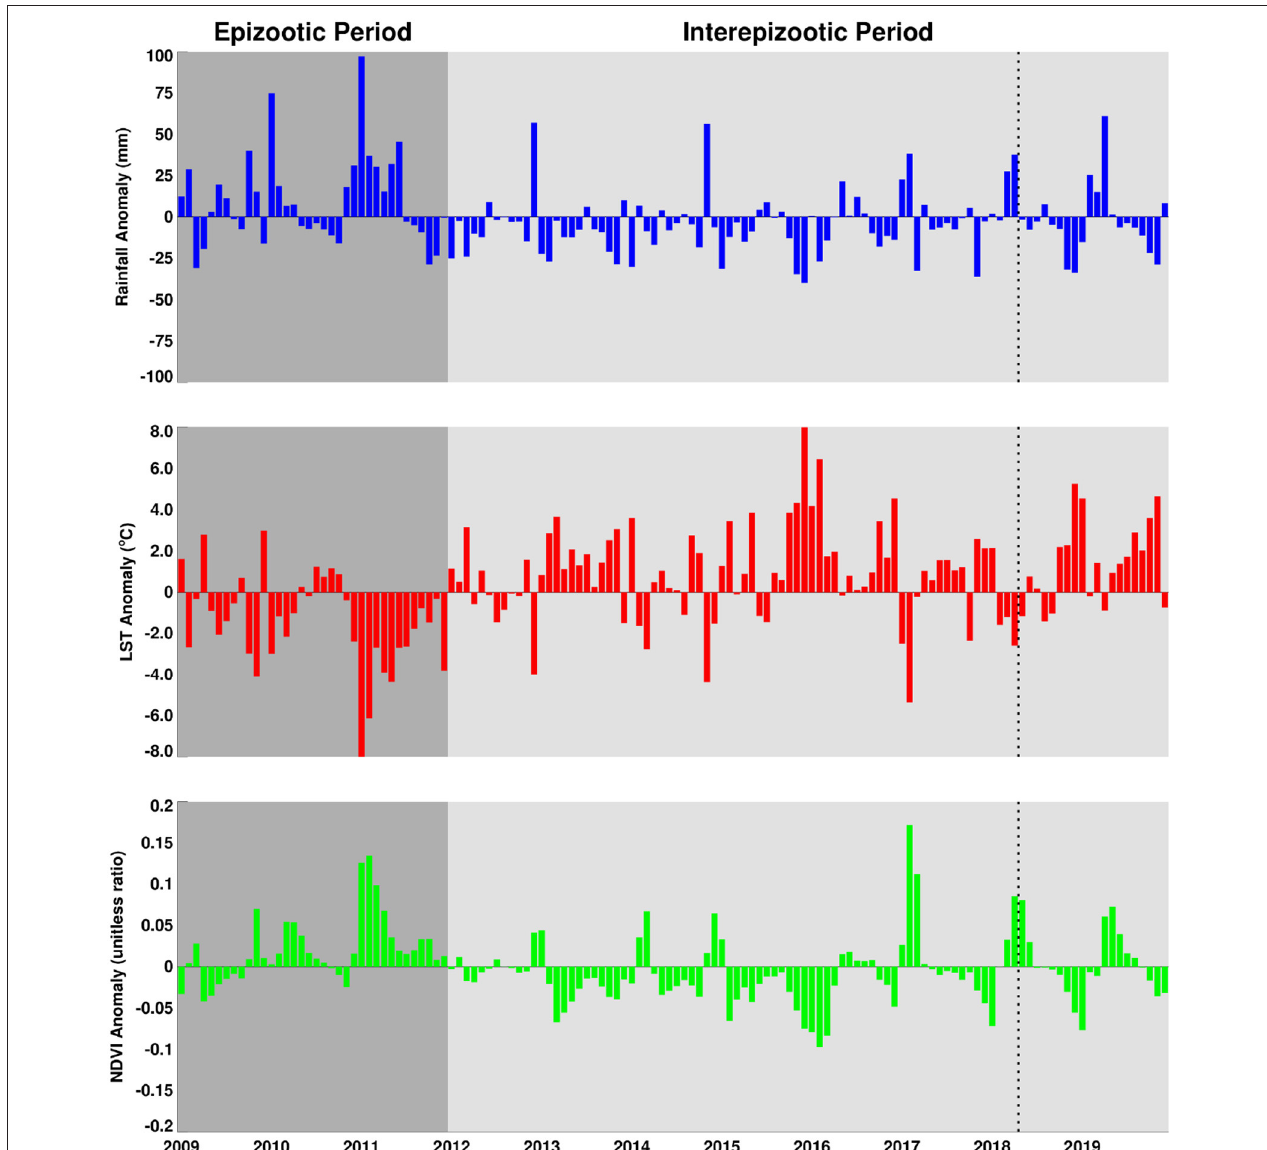
FIGURE 5 | Anomaly time series of rainfall, land surface temperature and normalized difference vegetation index for the period 2009–2019. The Rift Valley fever epizootic period (2009–2011) is shaded in dark grey and shows predominantly above normal rainfall, lower than normal land surface temperatures, and above normalized difference vegetation index and opposed to the interepizootic/post-epizootic period (2012–2019) with lower than normal rainfall and normalized difference vegetation index and persistence of higher than normal land surface temperatures marked by the extreme drought of 2015–2016. The dotted line shows